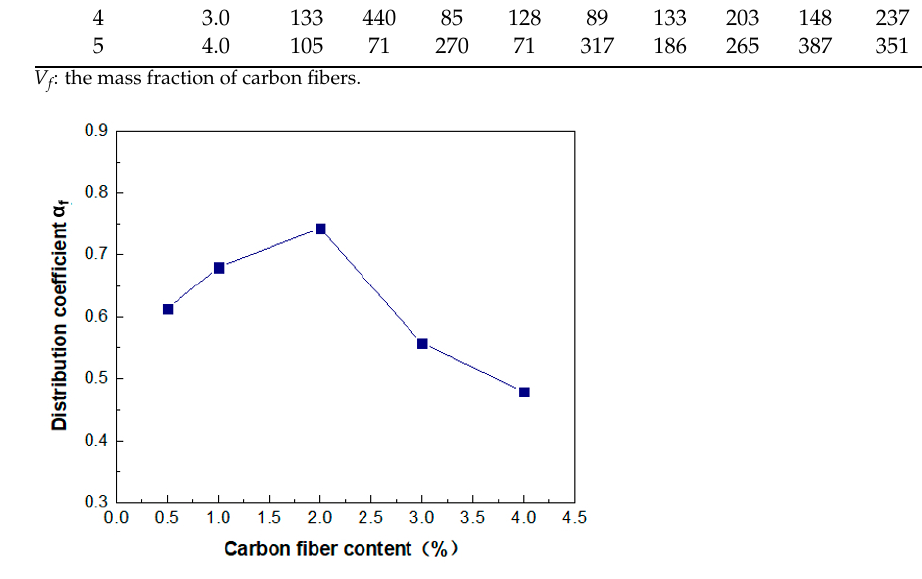
Figure 12. Fiber distribution coefficient α f of the composites with different carbon fiber contents.